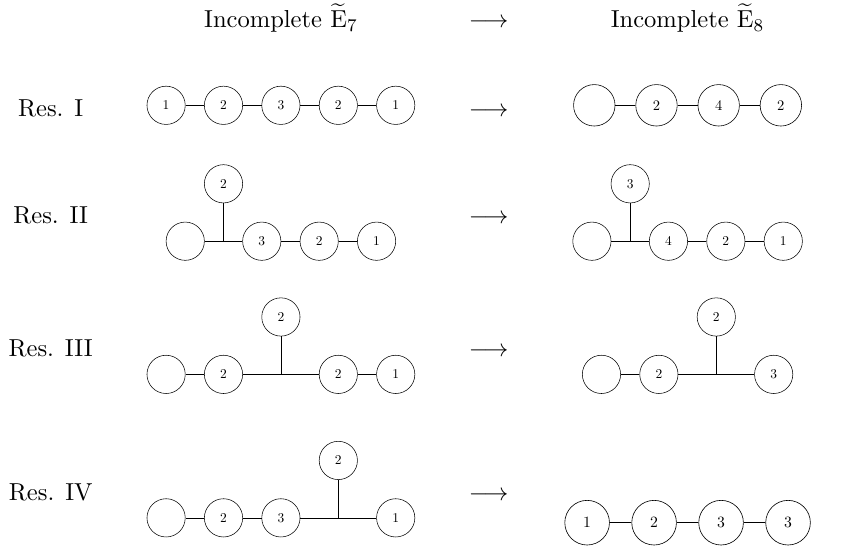
are Langlands dual of each other. But only 2 is the dual graph of the (cid:12)ber I (cid:3) ns . 2 0